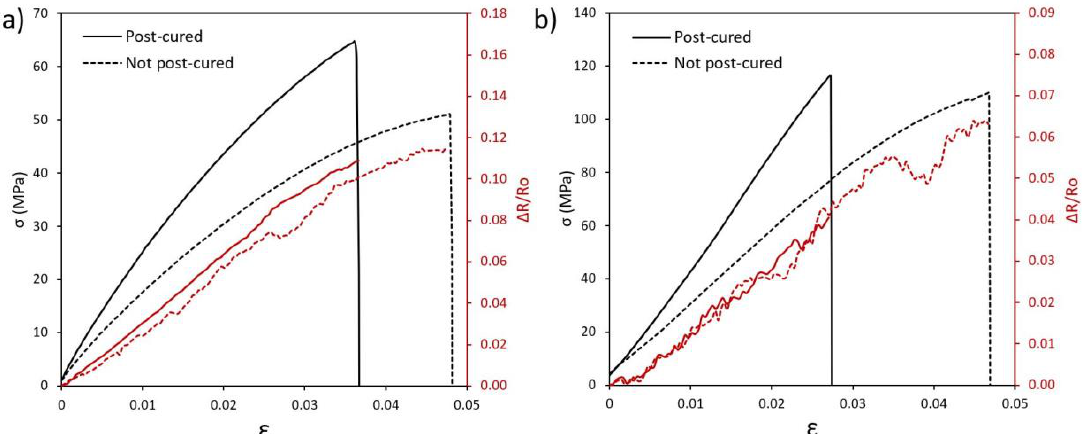
Figure 10. Examples of electromechanical tests comparing specimens with and without post-curing treatment in ( a ) tensile tests for specimens containing 0.100 wt % CNT and ( b ) three-point bending tests for specimens containing 0.050 wt % CNT.